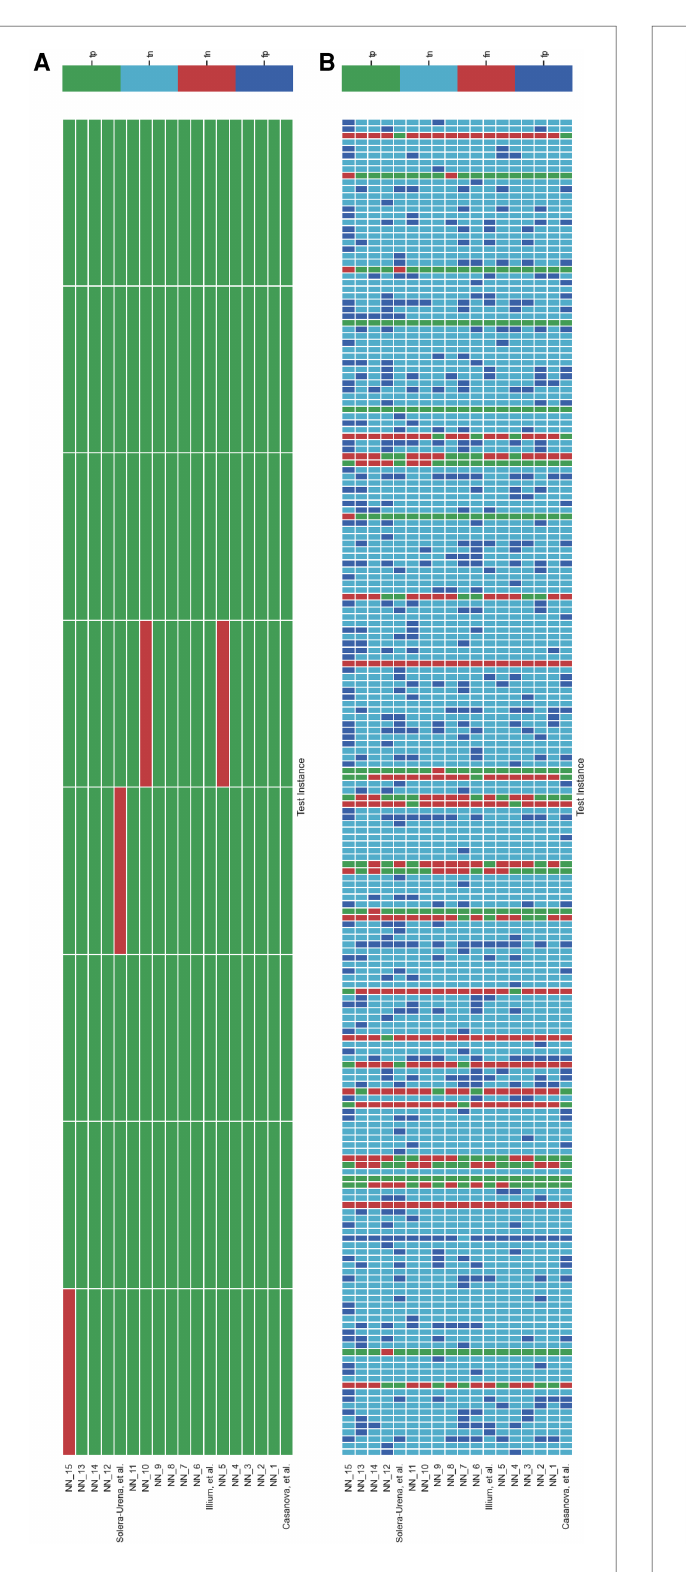
FIGURE A5 Schematic detailing the level of agreement as in Figure 6 with test instances with either a low sample rate (below 12kHz) ( A ) or high sample rate (above 12kHz) ( B